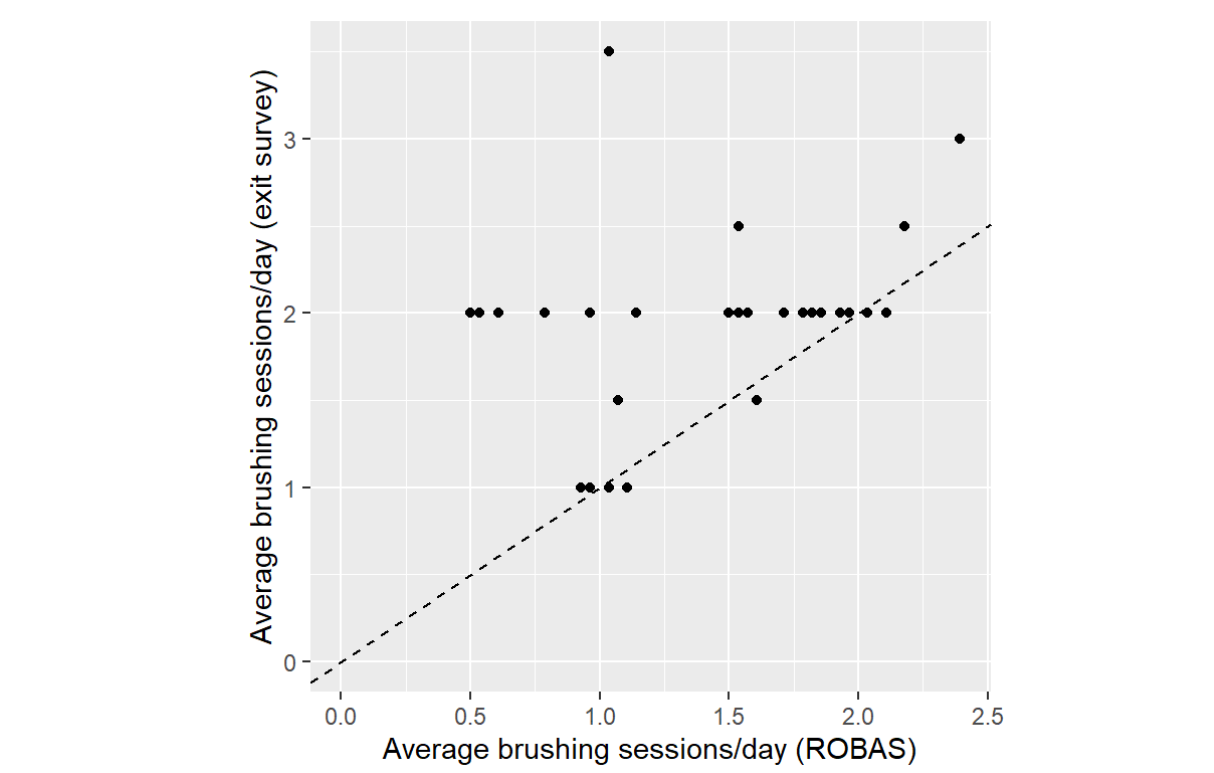
Figure 4. Mean daily brushing sessions by participants, as measured by ROBAS versus retrospective self-report. ROBAS: Remote Oral Behaviors Assessment System.